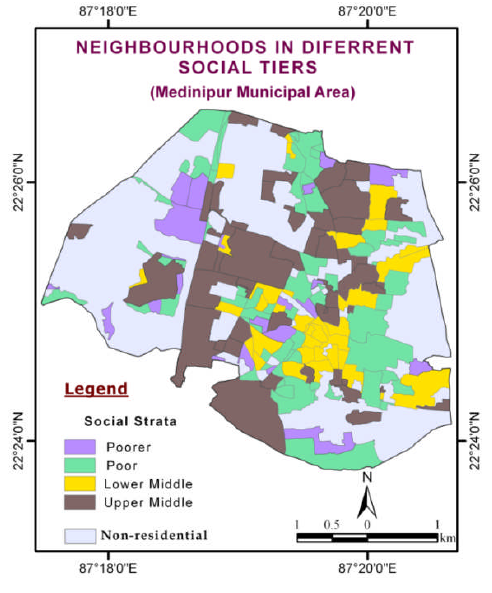
Figure 8. Status of